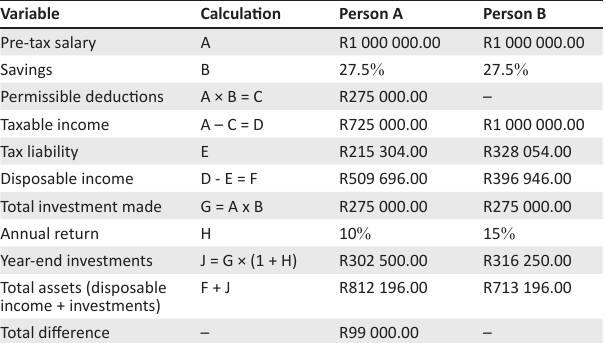
TABLE 1-A1: Reduced tax liability example.